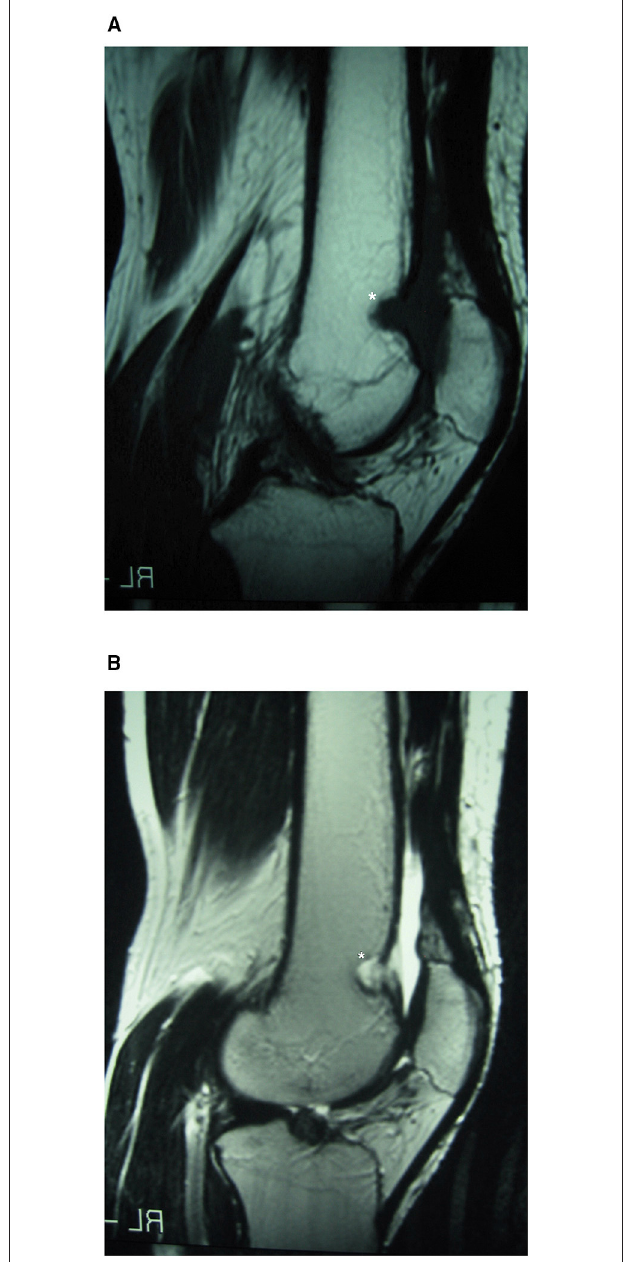
FIGURE 1 | Case 1: suprapatellar SH MRI. Conventional sagittal T1 (A) and T2 (B) MRI showing synovial haemangioma in the suprapatellar and supratrochlear synovial lining extending medially and eroding the supratrochlear cortical bone, with features of hyperintensity on T2-weighted imaging and hypo-/isointensity to muscles on T1. *Location of the Synovial Haemangioma tumor in the knee.